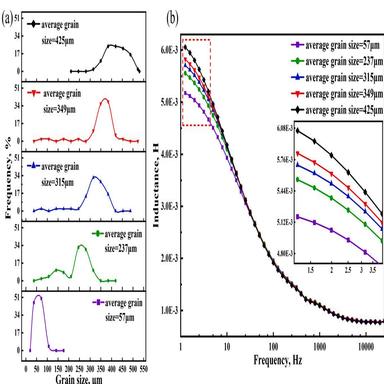
(a) Ferrite grain size distribution for samples with different holding time, (b) frequency-inductance curves of single ferrite microstructure with different grain sizes.